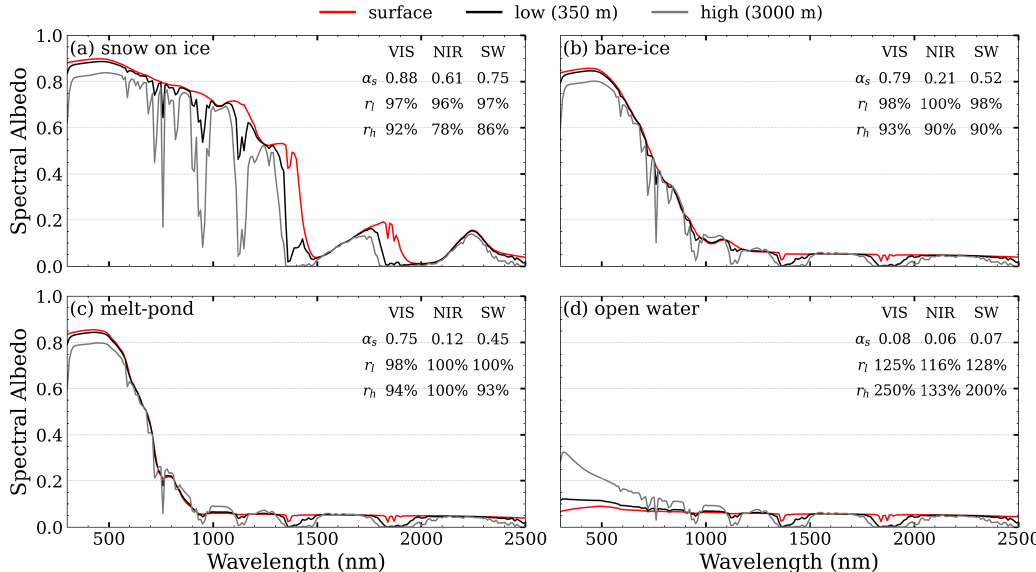
Figure 2. Spectral albedo computed by the RTM at various altitudes (350m as a black line and 3000m as a gray line) and the surface (red line).